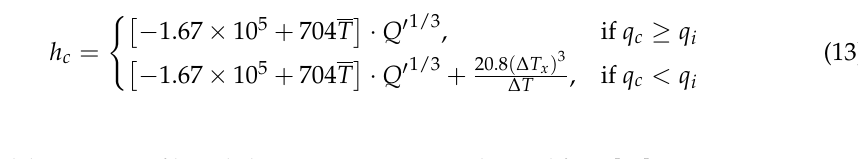
Table 2. Model properties of liquid aluminium. Properties obtained from